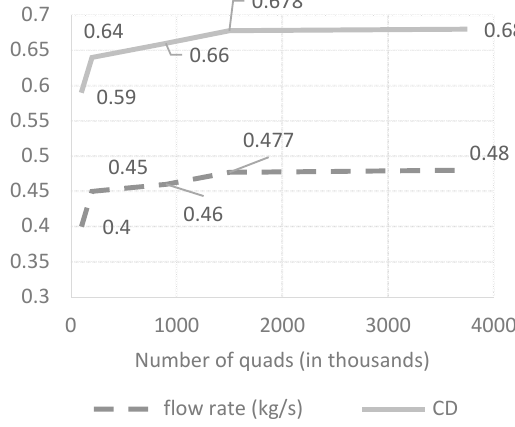
Figure 6. How the discharge coefficient (DC) and the mass flow rate changes with the grid resolution.